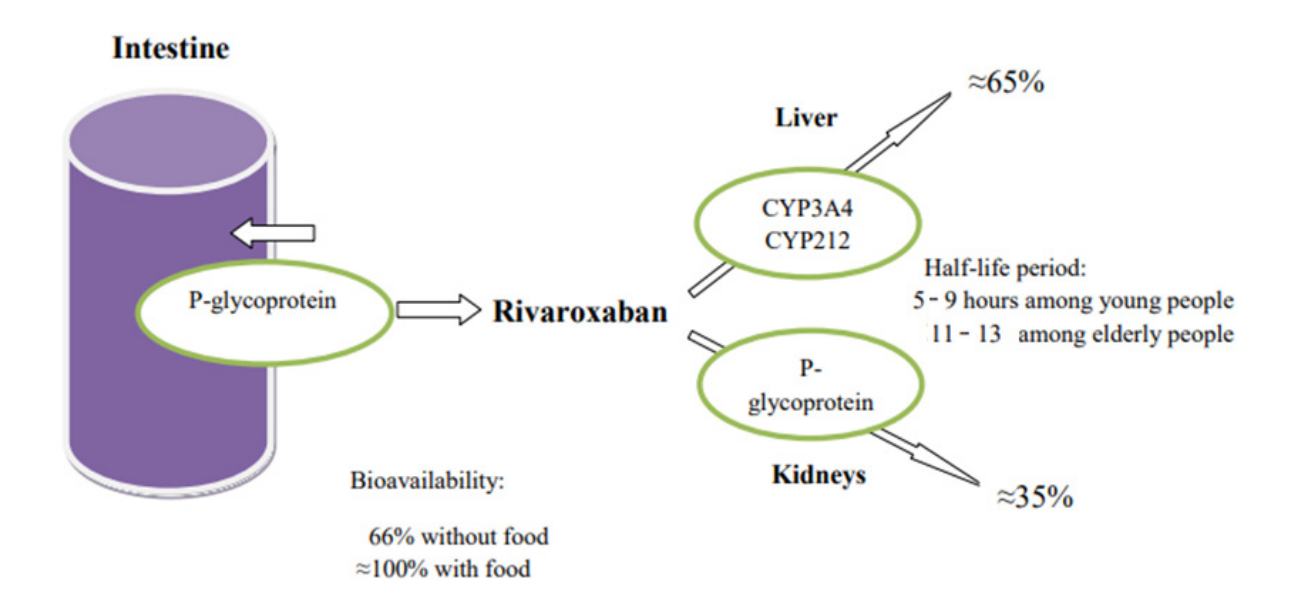
Figure 2. Enzymes involved in the metabolism of rivaroxaban .